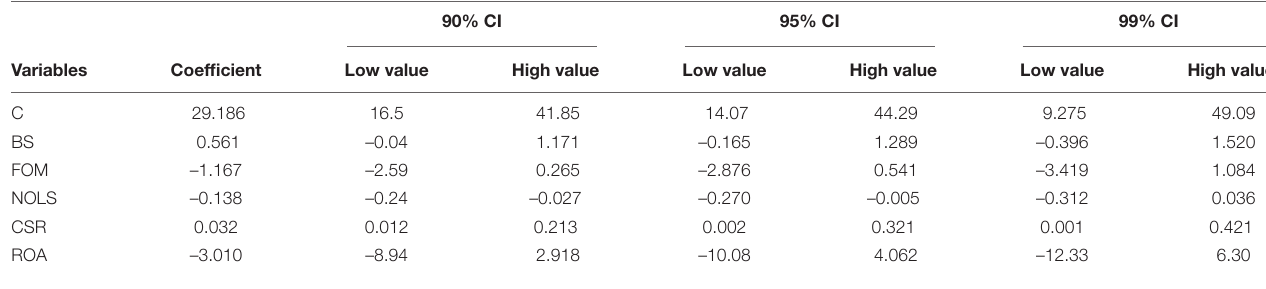
TABLE 11 | Confidence interval